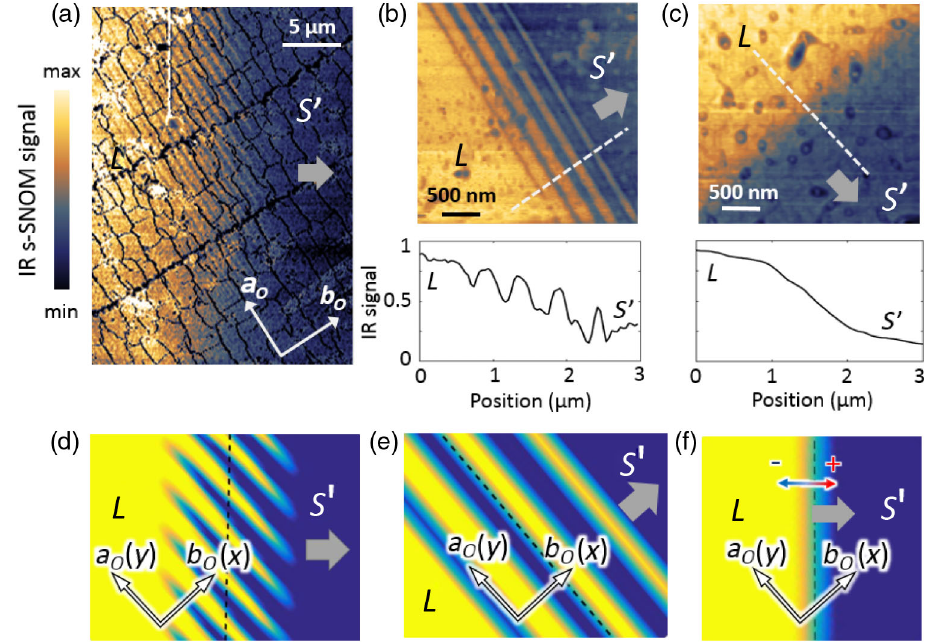
FIG. 3. Oriented stripe formation across the PB. (a) – (c) IR s-SNOM imaging (second harmonic) of S 0 - L phase boundaries on three different Ca 2 RuO 4 samples. Lower panels in (b) and (c): Line cuts of the s-SNOM signal along the dashed lines in the upper panels. (d),(e) Results of the numerical minimization of the free energy for PB oriented at 45° and 90° to the crystalline b indicates metal, and blue insulator. (f) shares the same parameter as (d) except using a larger driving force gradient B . The gray arrows in (a) – (f) indicate the direction of the L state expansion (normal of the PB) under an increasing